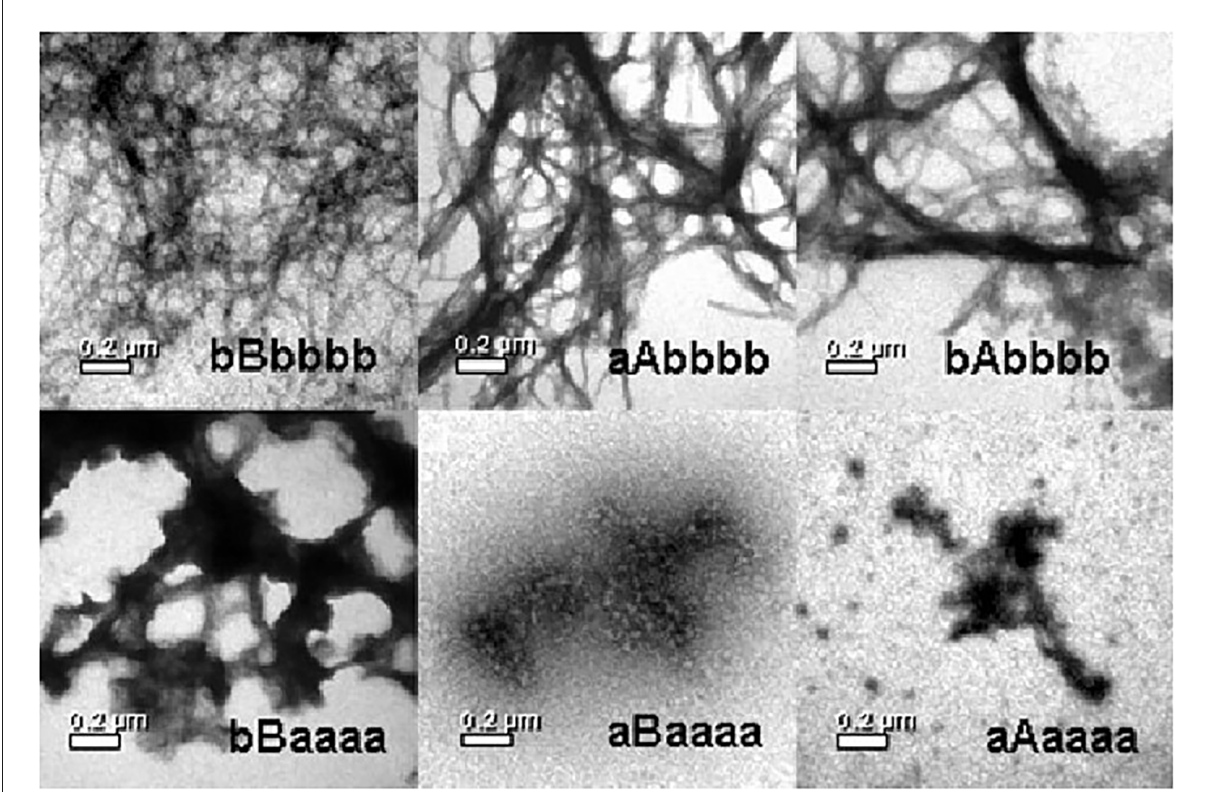
FIGURE3 Propensity of the chimeras to form amyloid fibrils (in bold, below). TEM images of stefin B (bBbbbb) , the chimeric proteins bAbbbb, aAbbbb , bBaaaa, aBaaaa, and stefin A (aAaaaa) at the plateau stage of the amyloid fibril formation. Reproduced from Kenig et al. (2006).